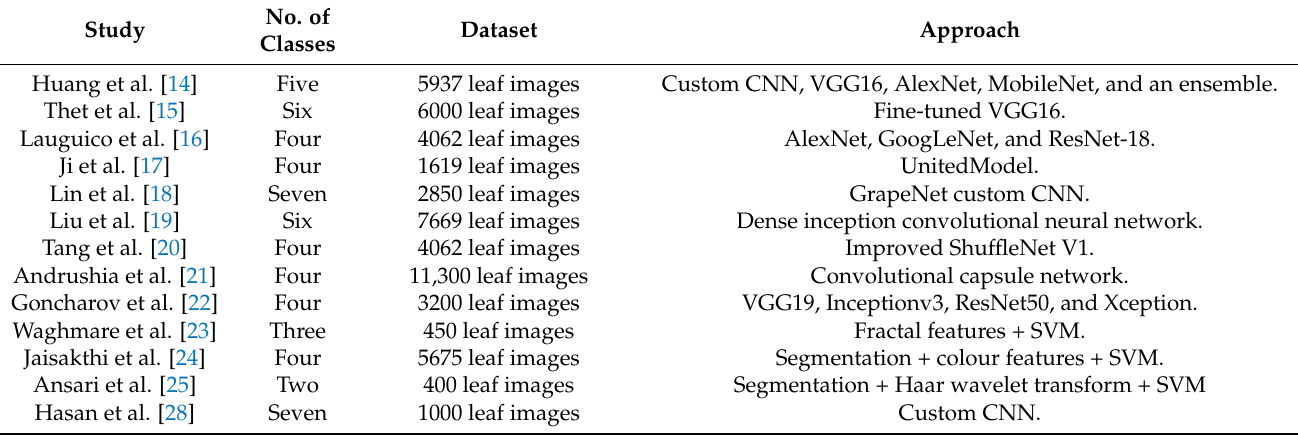
Table 1. The state of the art in classifying grape diseases. Each study included one class for the healthy